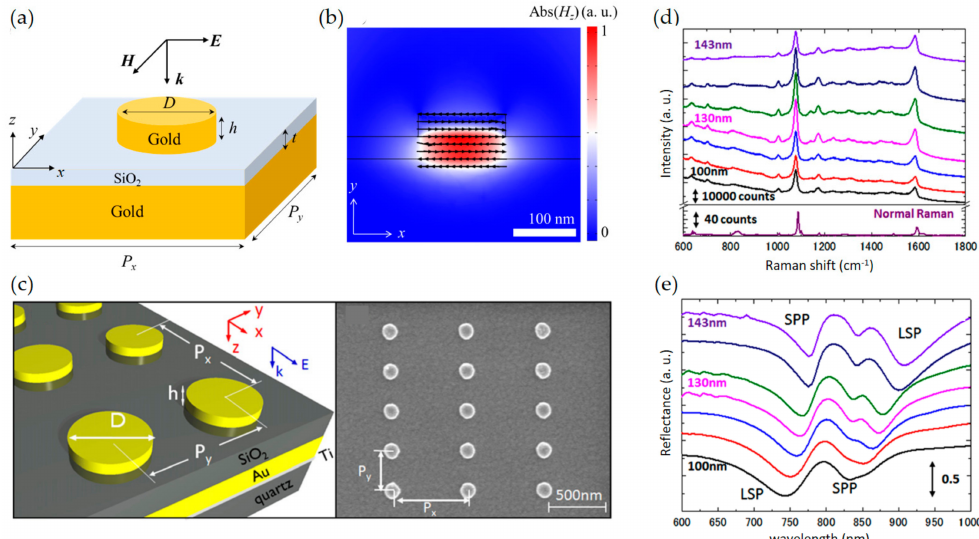
Figure 3. ( a ) Schematic configuration of nanodisk-based MM; Structural parameters are described. ( b ) Absolute value of H z -field profile on resonance. It shows the generation of current loops (black arrows). The resonance conditions are as follow: λ = 879 nm, D = 130 nm, h = 30 nm, t = 30nm, P x = 580 nm, P y = 300 nm; ( c ) Schematic illustration of double-resonances gold nanodisk array substrate (left panel) and its SEM image (right panel); ( d ) SERS spectra on double-resonances. The diameter changes from 100 to 143 nm (black to purple); ( e ) Reflectance spectra corresponding to ( d ). Parts ( c – e ) are reprinted from Reference [87], with the permission of AIP